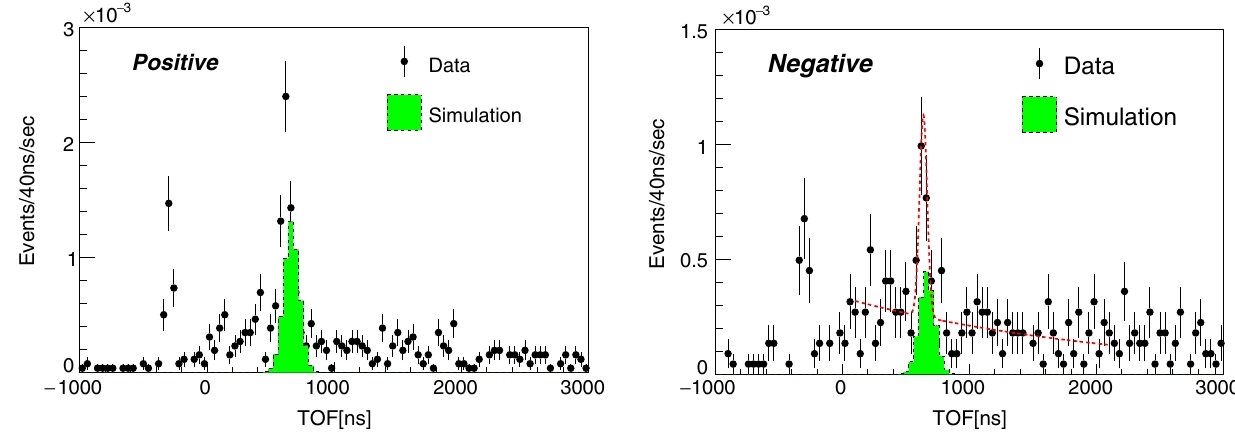
FIG. 8. The ToF spectra for the positive extraction (top) and negative extraction (bottom). The red dotted line in the negative extraction indicates the fitted function, and the green histograms indicate the simulated ToF distributions. Numbers of incident μ þ ’ s for positive and negative extractions were 3 . 4 × 10 10 and 2 . 7 × 10 10 , respectively. Peaks around − 300 ns were prompt positrons contaminated in the surface muon beam.